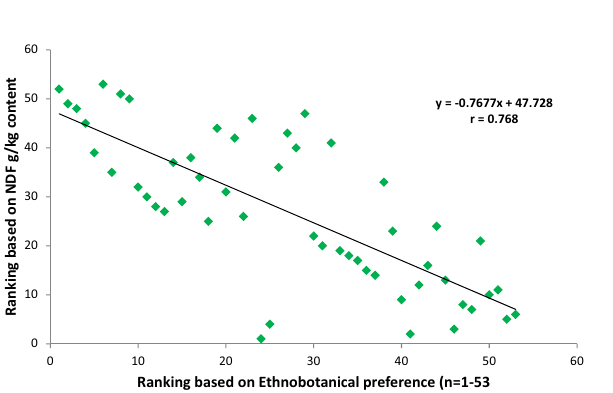
Figure 4. Positive correlation (r) between ethnobotanical preferences ranking of fodder grass versus order of priority based on CP content (high to low).